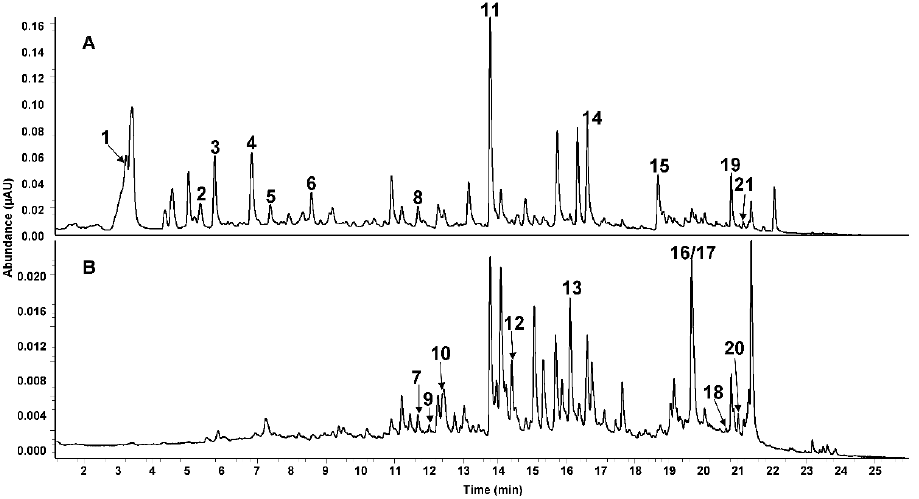
Figure 1. UHPLC chromatograms of RR. ( A ) 280 nm; ( B ) 350 nm. For peak numbers see Table 2.